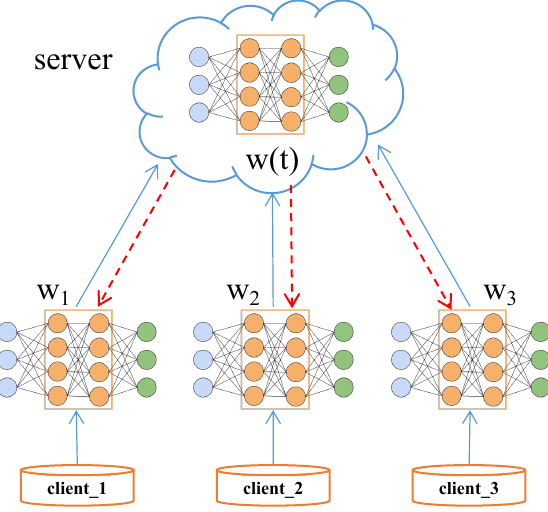
Figure 2. Federal learning